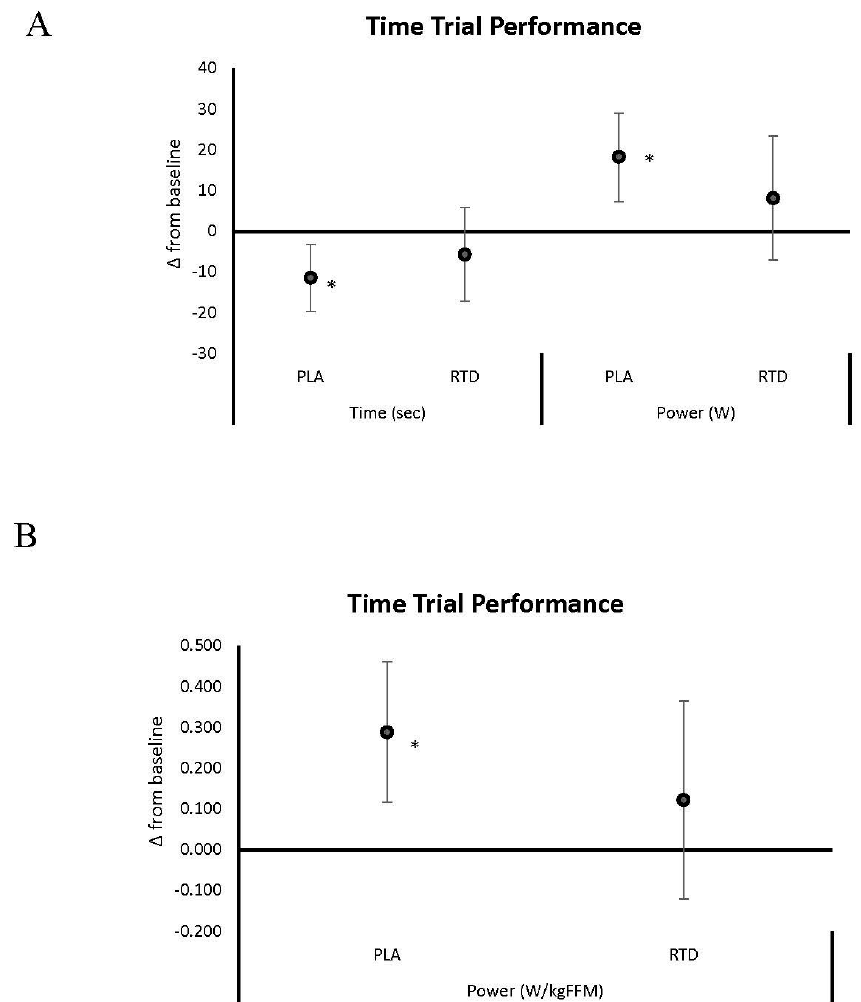
Figure 5. Data present mean change (95% CI) in 4 km time-trial performance from baseline expressed in completion time and absolute power output ( A ); and relative power output ( B ). Confidence intervals not crossing zero are statistically significant ( p < 0.05). * represents p < 0.05 difference from